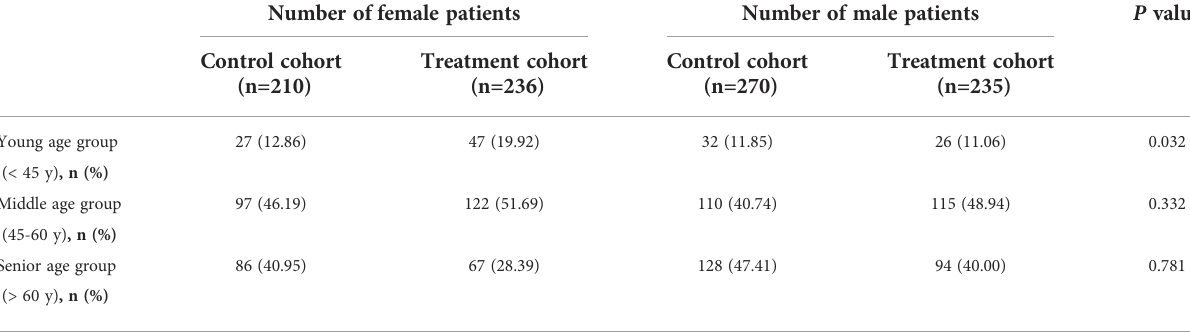
TABLE 4 Summary of Gender Composition of Surgery for lung nodule or mass by Age